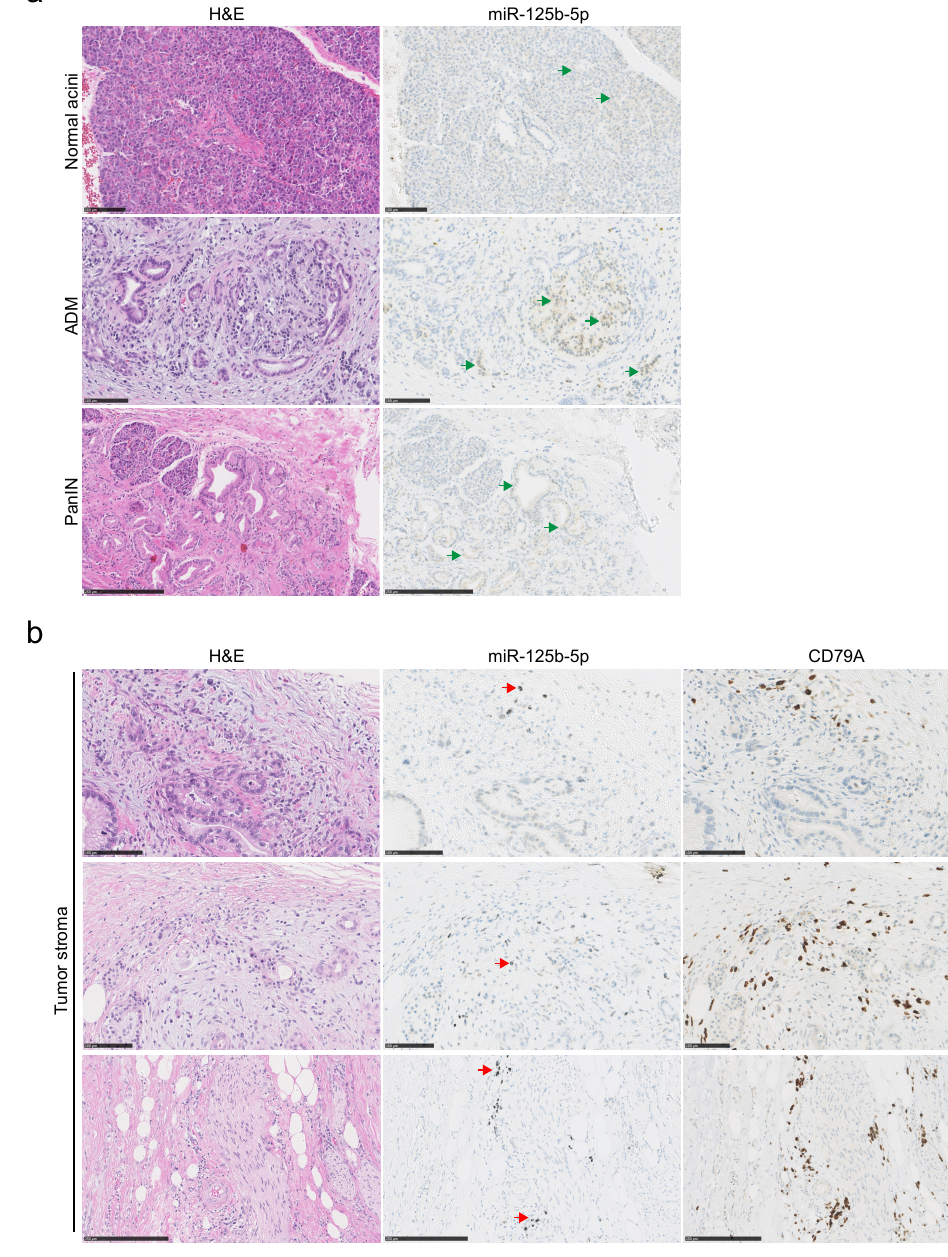
Figure 3. MiR-125b-5p detection by in situ hybridization in pancreatic cancer tissues. Serial FFPE tissue sections were stained with H&E or a DIG labeled miR-125b-5p probe. MiR-125b-5p expression is detected by silver staining resulting in brown / black coloring, whereas nuclei are stained with hematoxylin in blue. ( a ) Representative images of low expression of miR-125b-5p, (green arrows), in untransformed pancreatic acinar cells and cells that underwent acinar to ductal metaplasia (ADM) or pancreatic intraepithelial neoplasia (PanIN). Scale bars are 100 µ m in the normal acini and ADM; scale bar is 250 µ m in the PanIN. ( b ) Representative images of cells in the tumor stroma with high expression of miR-125b-5p (red arrows). Corresponding tissue sections are stained with H&E or the B-lymphocyte lineage marker CD79A antibody by immunohistochemistry (brown). Scale bars are 100 µ m in the top two rows; scale bars are 250 µ m in the bottom